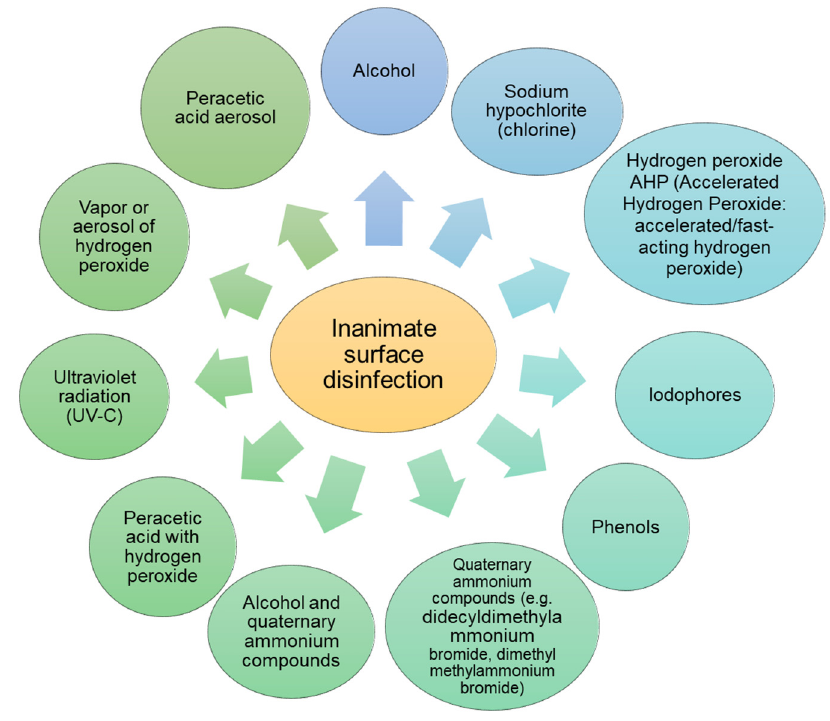
Figure 6. Inanimate surface disinfection.